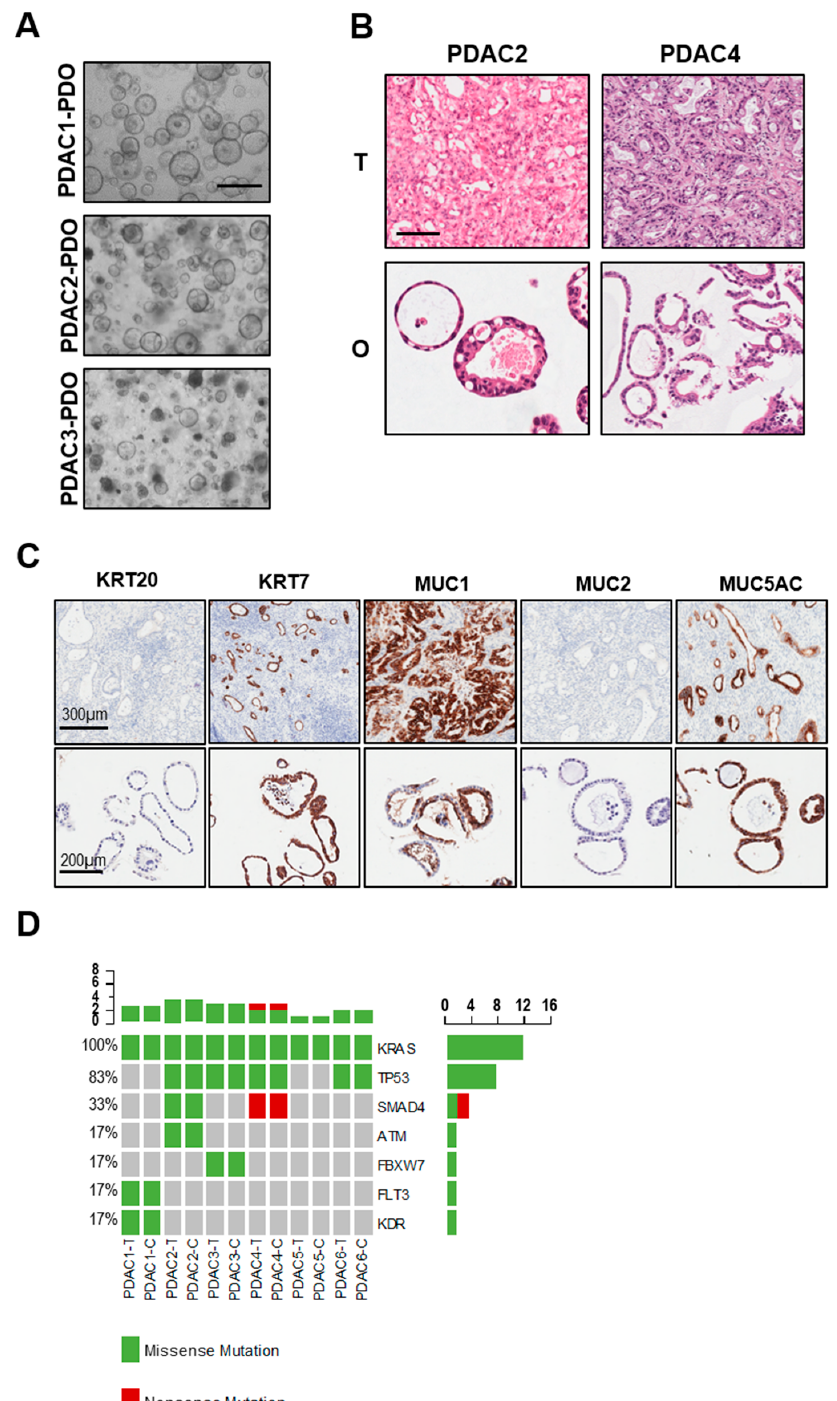
Figure 2. Histopathological and molecular characterization of PDAC-PDOs. ( A ) Bright-field images of established PDAC-PDOs. Scale bar, 500 µm. ( B ) Haematoxylin and eosin stained sections of PDAC organoids and their parental tumor tissues. Scale bar, 200 µm. ( C ) Histopathological characteristics of PDAC1 organoids and their corresponding tumor tissues. Immunohistochemistry for KRT20 (negative), KRT7 (positive), MUC1 (positive), MUC2 (negative), MUC5AC (positive) of paraffin-embedded organoid culture and matched parental tumor tissue. ( D ) Non-synonymous somatic mutations found in PDAC organoids and their parental tumor tissues through high-coverage targeted sequencing.